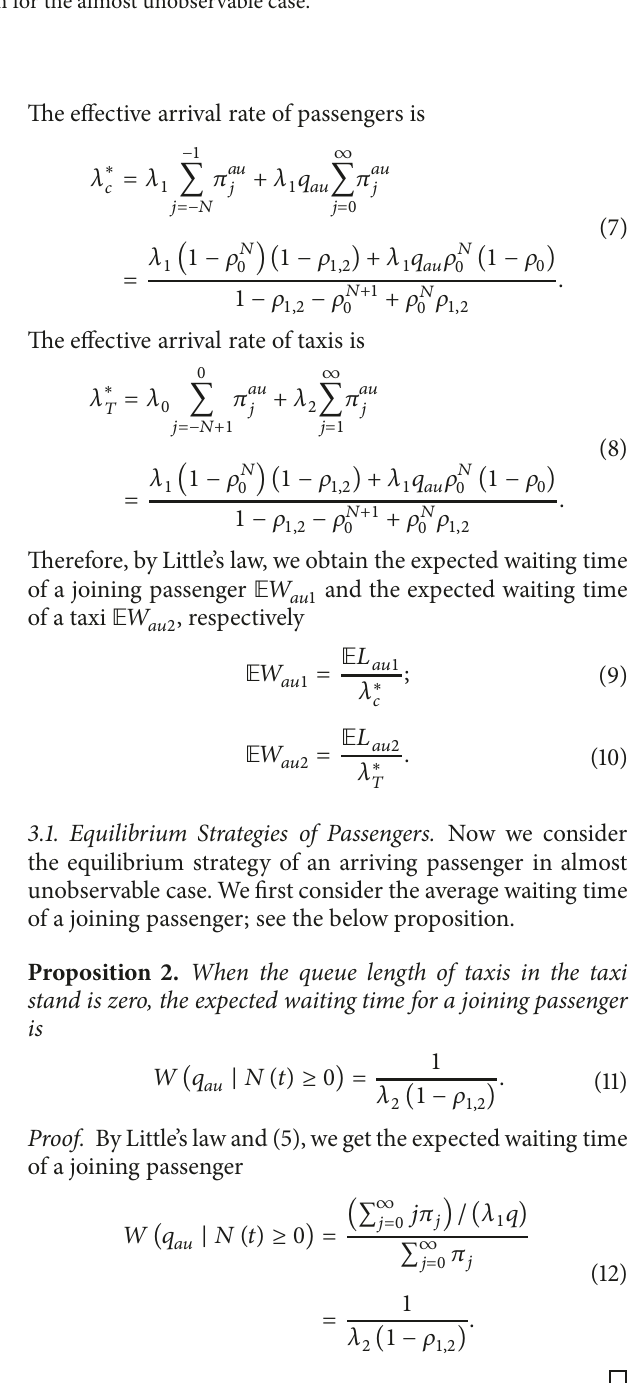
Figure 2: State transition diagram for the almost unobservable